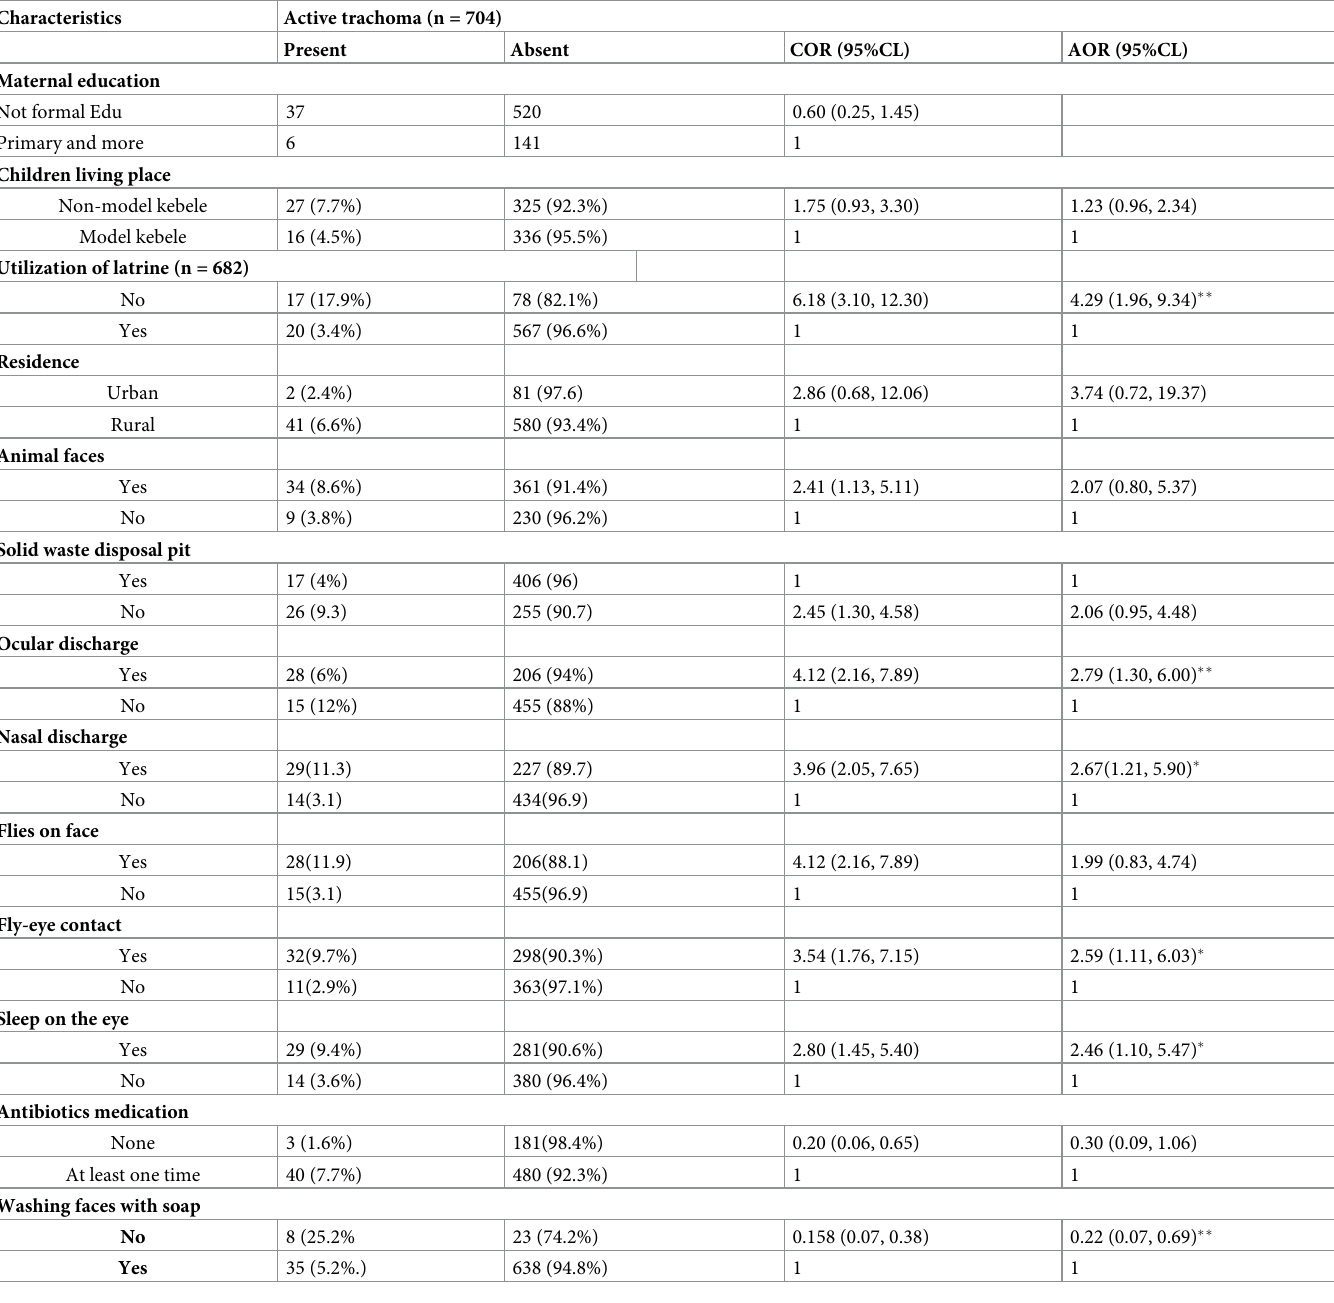
Table 4. Regression analysis of associated factors of active trachoma among children aged (1–9 years) from Dangila district, northwest Ethiopia, 2019.